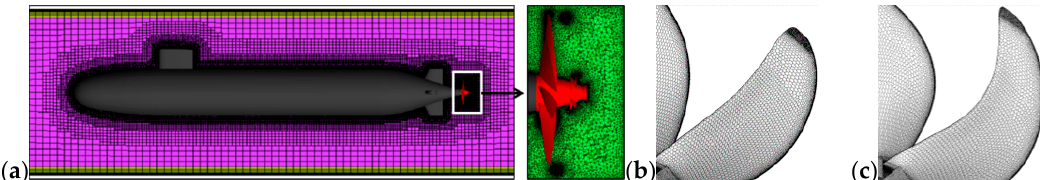
Figure 3. Computational grids for flow over the entire body and propellers: ( a ) entire grids and rotating part of grids, ( b ) surface grids on Model-A and ( c ) surface grids on Model-B. The numbers of grids in the rotating part for the propeller and the non-rotating part for Suboff body are 5.8 and 4.6M, respectively. The conservation equations of mass and momentum for